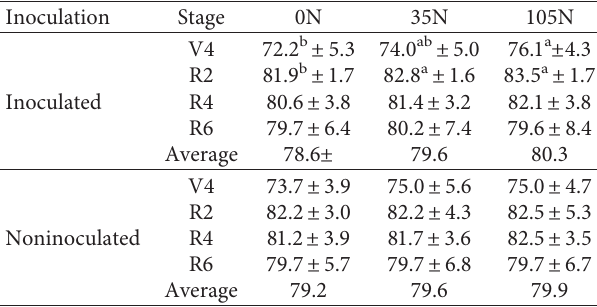
Table 5: The effect of different fertilization rates on NDVI at different stages of soybean’s (cv. Bogl´ar) life cycle, averaged among